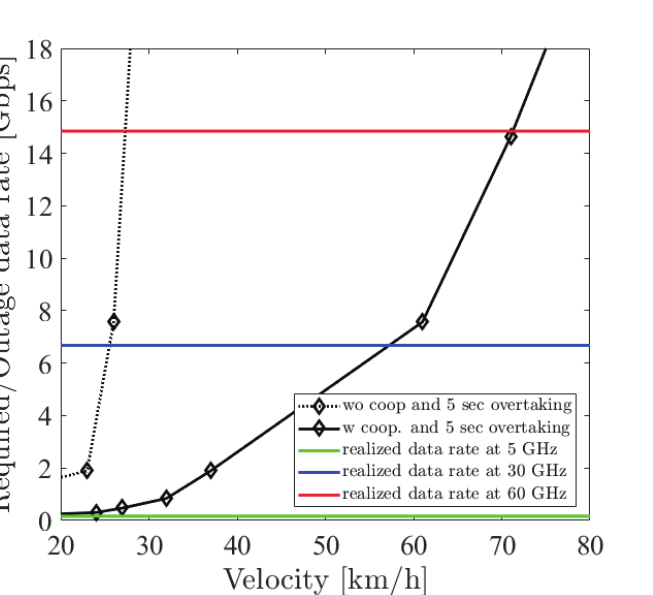
Figure 21. Required data rate using a non-linear spacing LiDAR sensor and the 0.01% outage data rate realized by the 5, 30, and 60 GHz bands under d be = 10